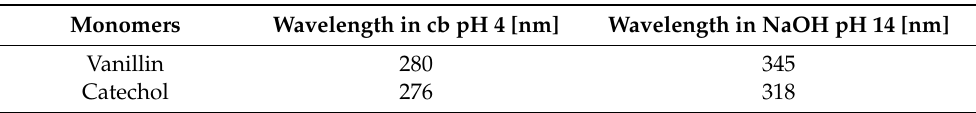
Table 2. Wavelengths of the absorption maxima of investigated monomers vanillin and catechol